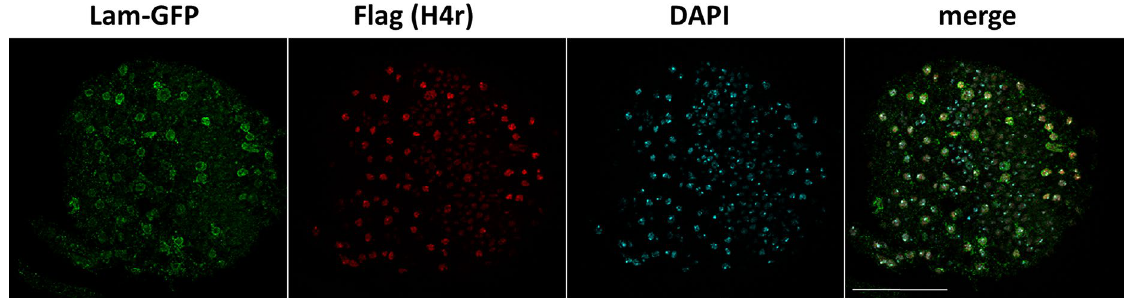
Figure 2. Colocalization between cholinergic neurons (green) and H4r expressing cells (red) in the larval brain (eye disc). 69.2% of H4r-expressing cells are cholinergic neurons. Scalebar refers to 50 µm.